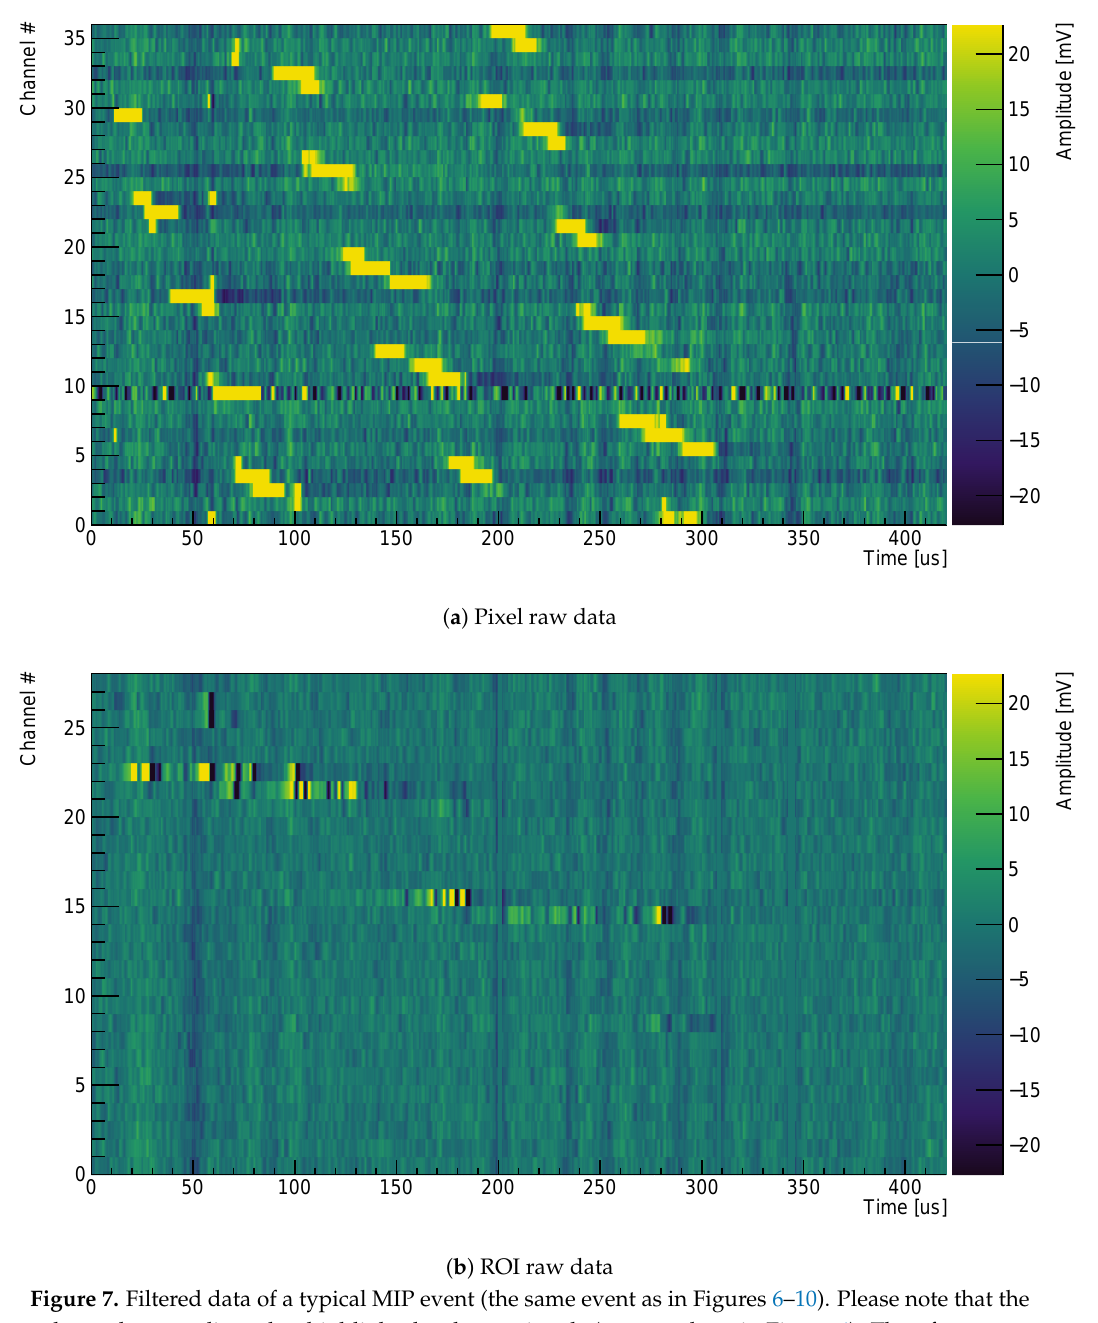
Figure 7. Filtered data of a typical MIP event (the same event as in Figures 6–10). Please note that the color scale was adjusted to highlight the charge signals (same scale as in Figure 6). Therefore, most signal peaks are above/below the maximum/minimum of the color scale. The full range of a typical signal can be seen in Figure